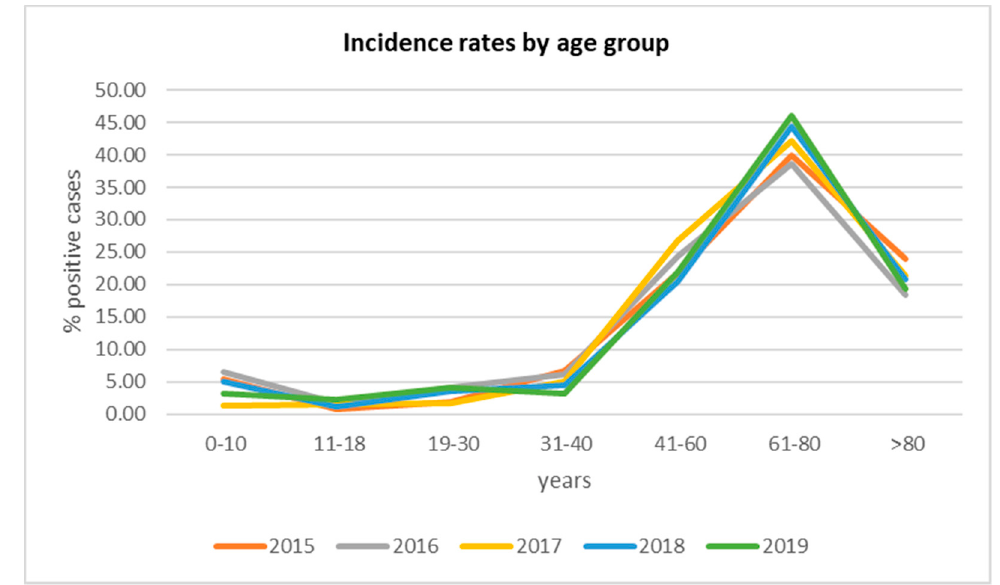
Figure 3. Distribution of positive cases by age group.